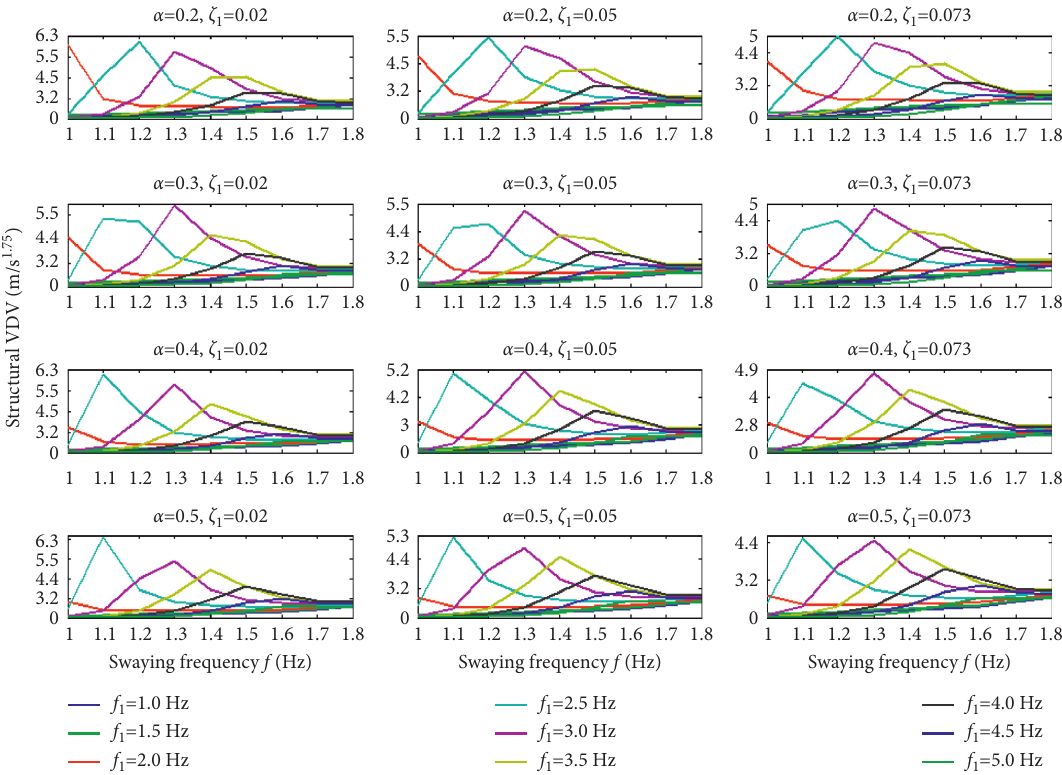
Figure 24: The structural VDV results when f